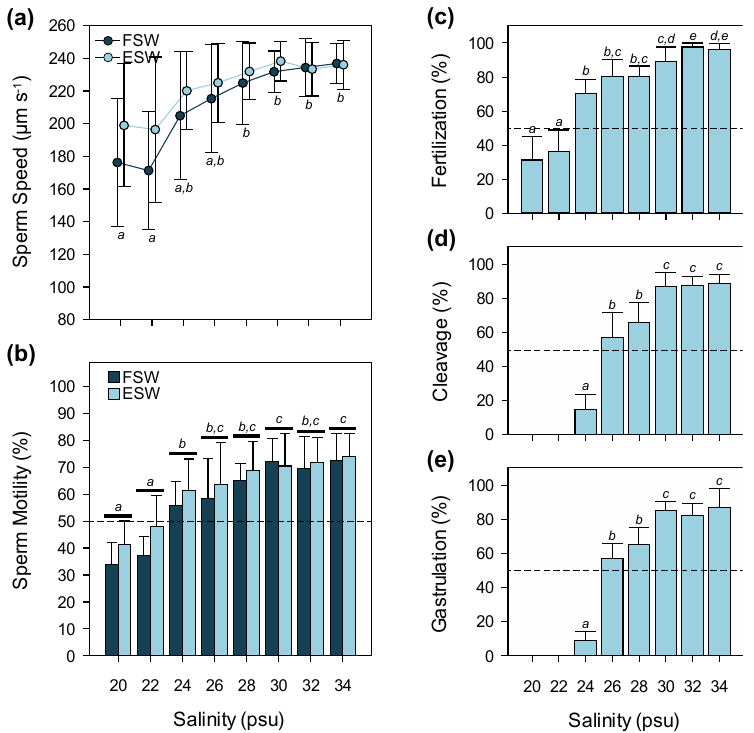
Figure 3. Effect of salinity on sperm behavior, fertilization, and early development: ( a ) sperm speed (points slightly displaced for clarity); ( b ) proportion of motile sperm, and proportion of eggs undergoing ( c ) fertilization; ( d ) cleavage; and ( e ) gastrulation ( n = 5). Letters above error bars (± SD) indicate significant differences based on post hoc pairwise comparisons with corrected p- values. FSW = 0.2- μ m filtered seawater (control); ESW = solution with water-soluble egg extract.